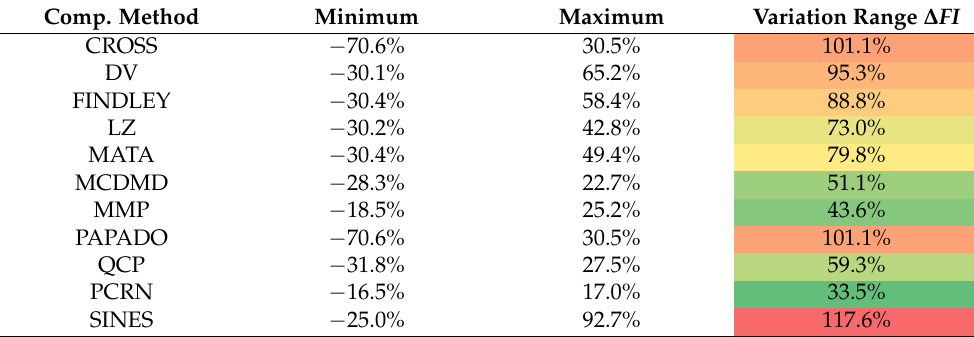
Table 10. Results of the ∆ FI statistics for 11 methods at different N x —minimum and maximum values and the variation